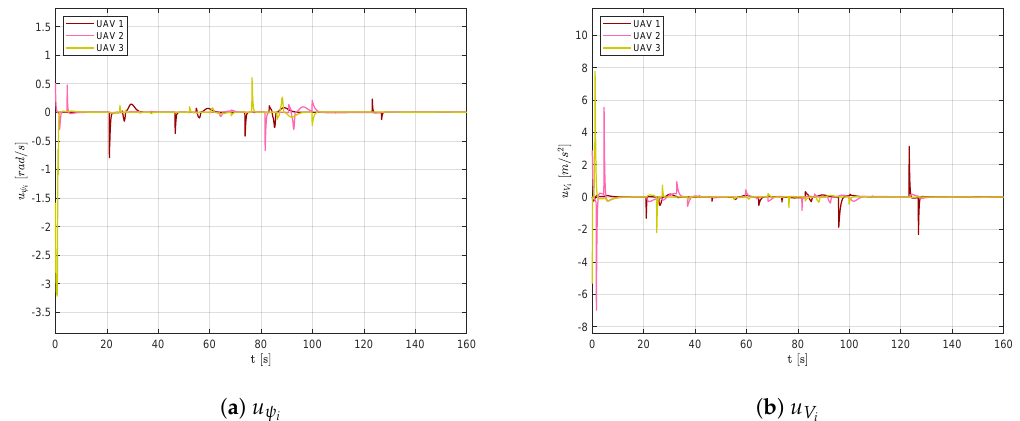
Figure 10. Scenario #1—three aircraft: control signal computed by TTCAA.